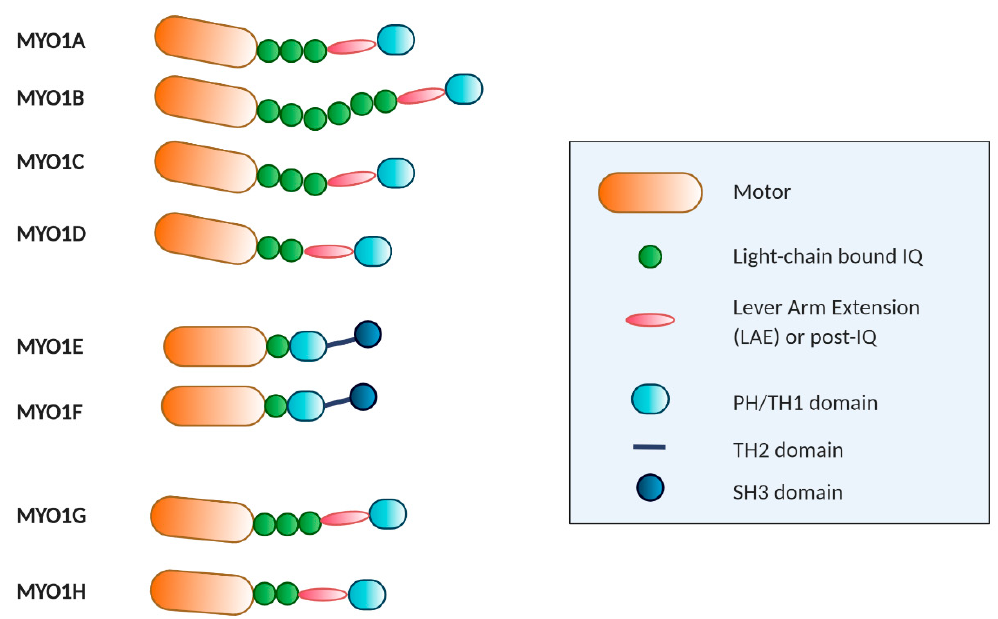
Figure 1. Schematic representation and structure of human unconventional type 1 myosins. All myosins comprise conserved motor heads (orange), different numbers of isoleucine-glutamine (IQ) motifs (green), a helical region (pink), IQ and helical extension comprising the neck region, and distinct tails with various functional domains. Long-tailed myosins, such as MYO1E and MYO1F, also have an Src homology 3 domain (SH3) domain for protein–protein interaction.